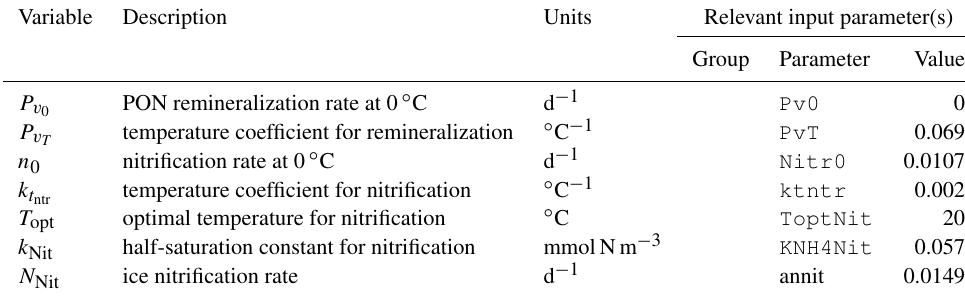
Table A11. Notation and description for input parameters related to remineralization and